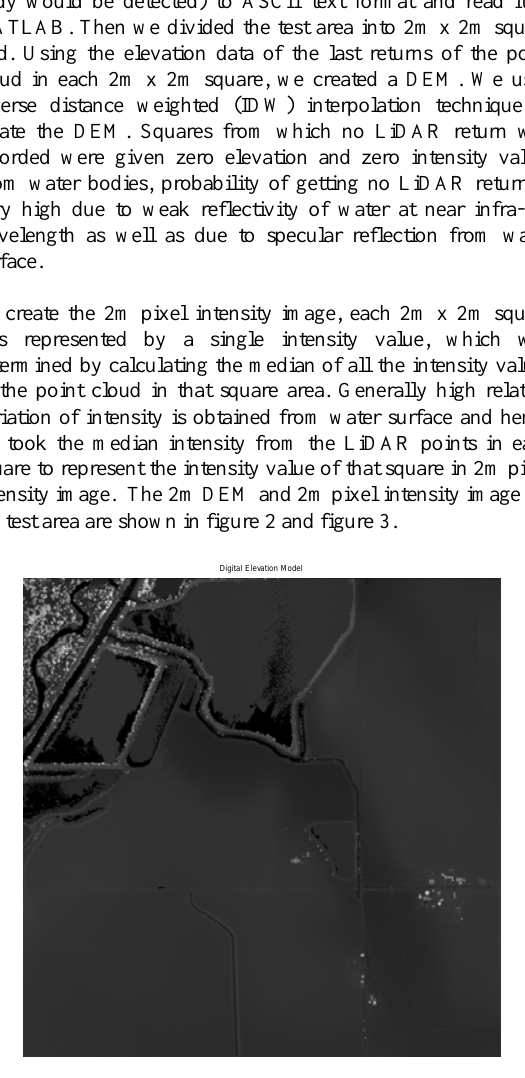
Figure 2. 2m DEM of the test area in L’Anguille river basin